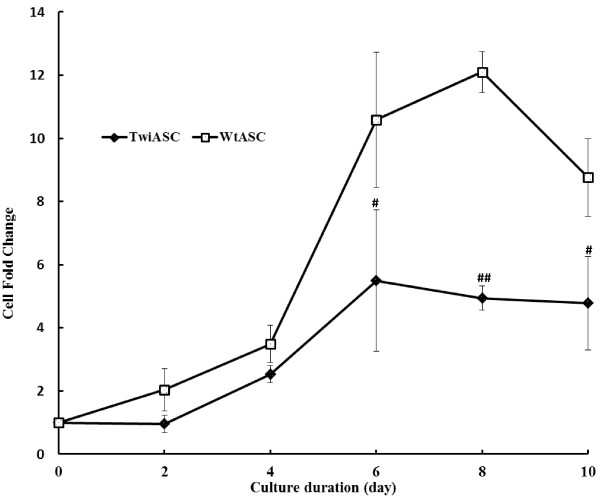
Growth curve analysis of TwiASCs and WtASCs. The cells were originally seeded at 500 cells/cm2 in 56.7 cm2 Nunc cell culture plates and cultured for 10 days. Fold increase in cell number was analyzed every 2 days throughout the culture period and was calculated by comparing the cell number at each time point to the original plating cell number. # means P< 0.05 vs WtASCs on day 6 and day 10 respectively, and ## means P< 0.001 vs WtASCs on day 8 (t-test, n=3).